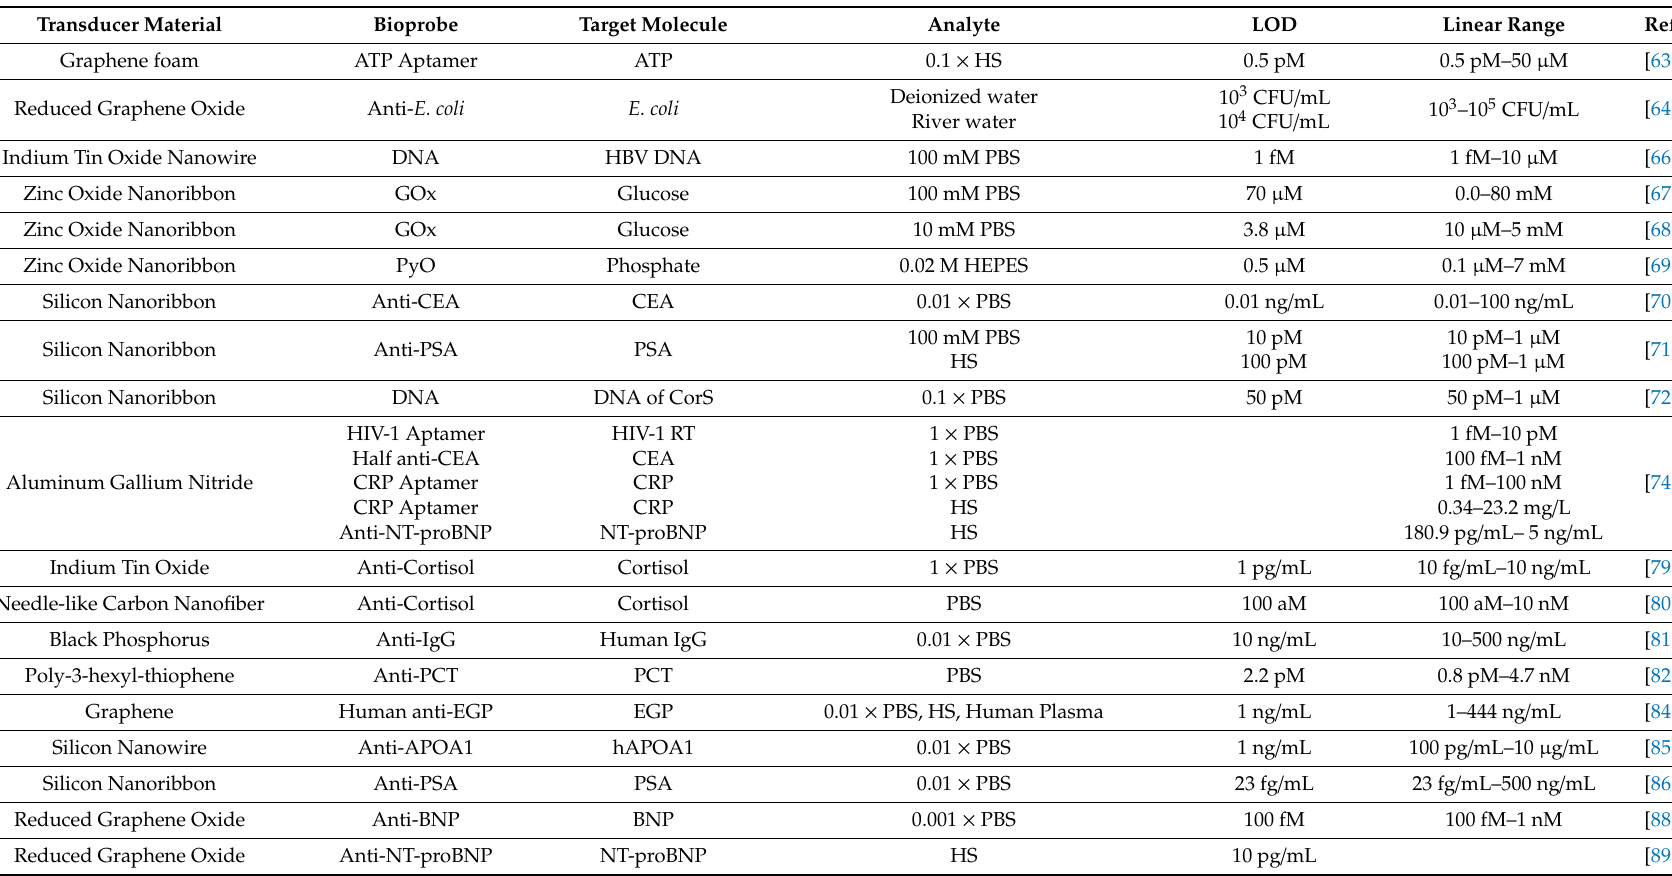
Table 1. Summary of remarkable publications of FET biosensors for biomedical applications from 2016 to early